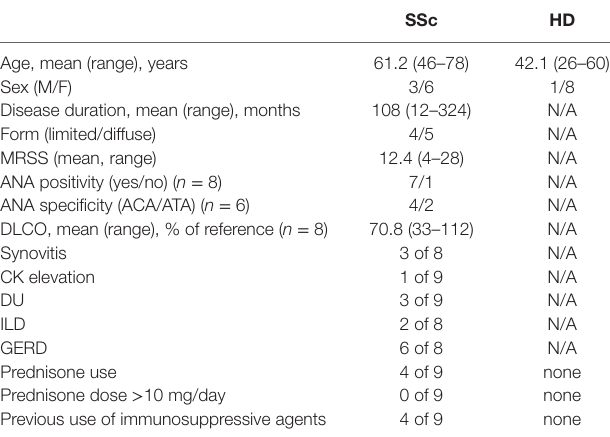
TaBle 1 | Clinical characteristic of the fibroblast